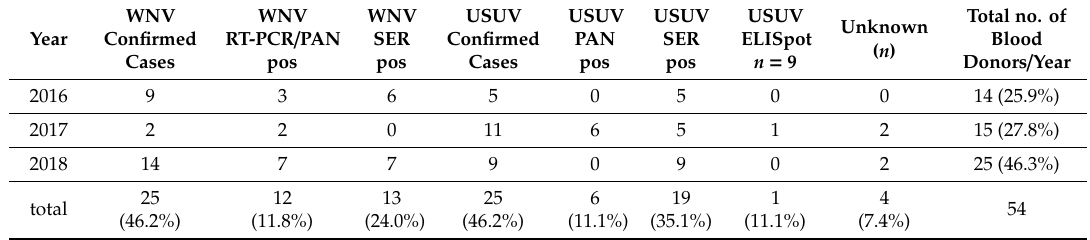
Table 1. Molecular, serological, and immunological results in 54 blood donors distributed for each year of observation. WNV—West Nile virus; USUV—Usutu